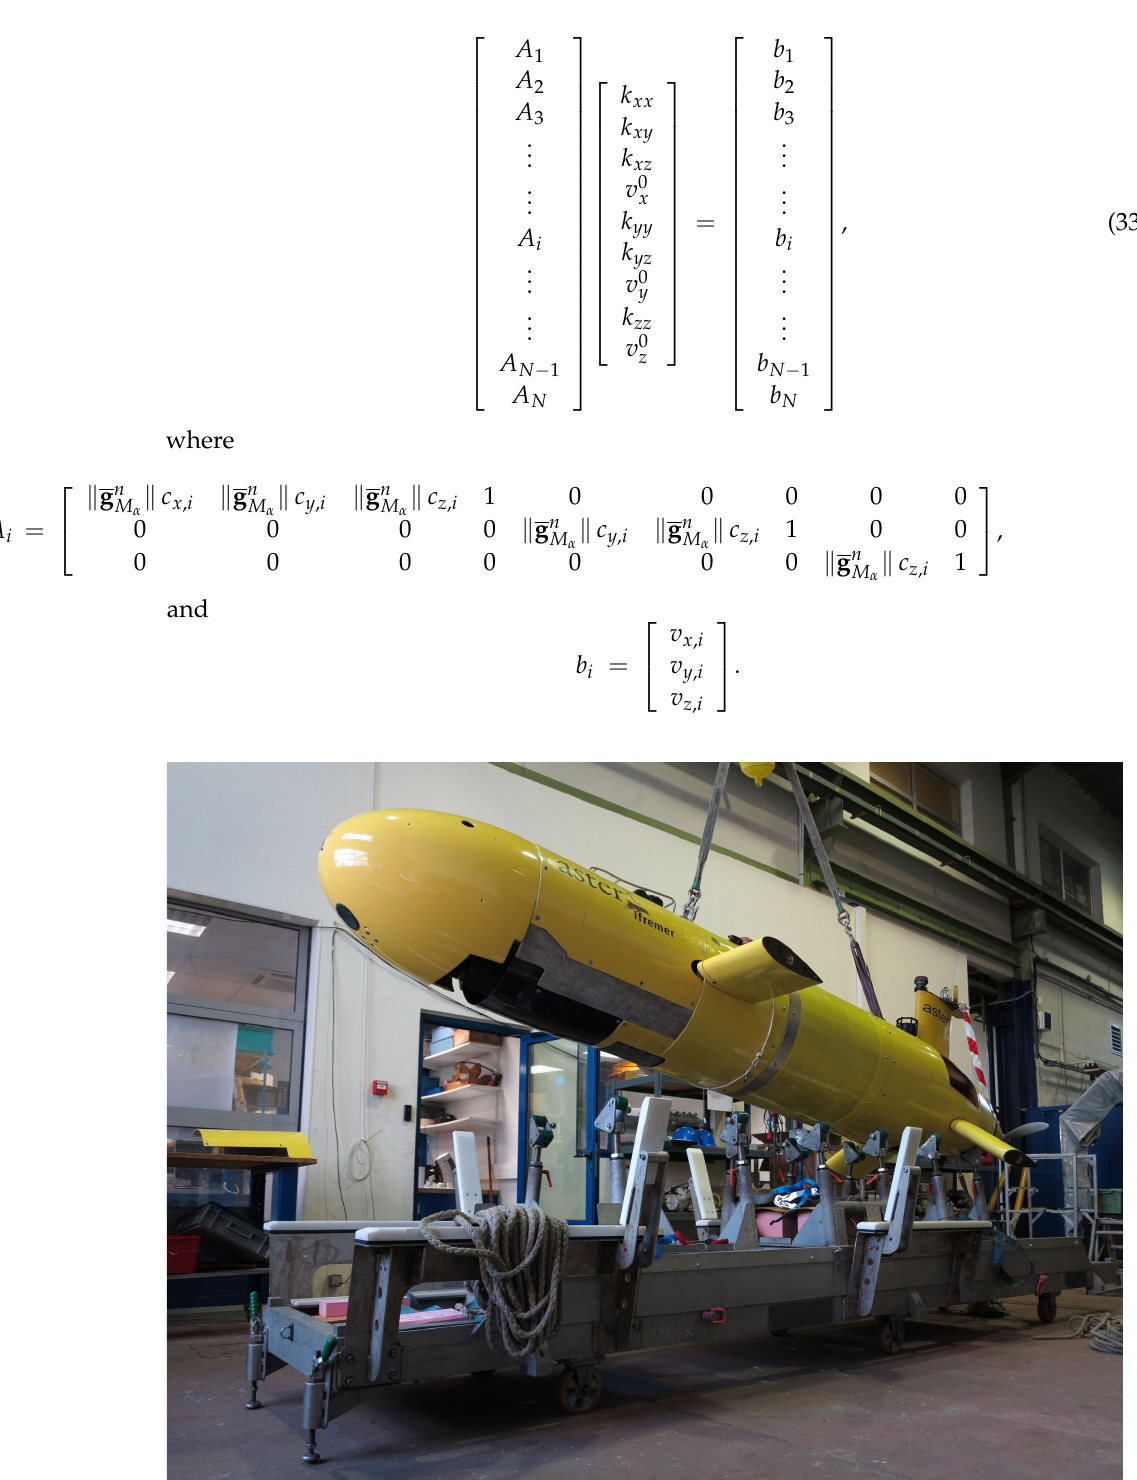
Figure 3. View of the AUV during the manipulation performed to adjust the internal parameters of the GraviMob system in one of the tilted positions. The AUV can thus be tilted along the roll, pitch and yaw